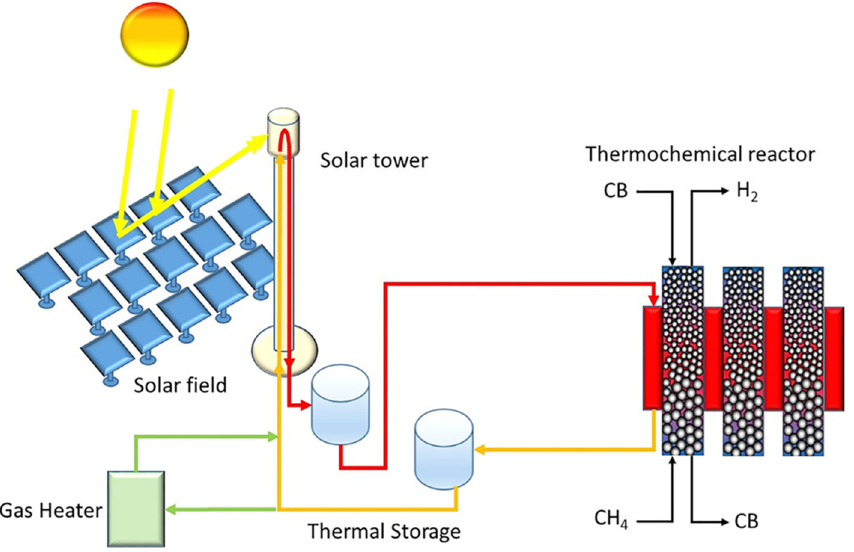
Figure 2. Sketch of a novel concentrated solar energy-driven version of a theoretical plant for catalytic thermal pyrolysis of CH 4 with CB as a catalyst, with the addition of a gas heater. (Adapted from Ref. [28] with Wiley permission).